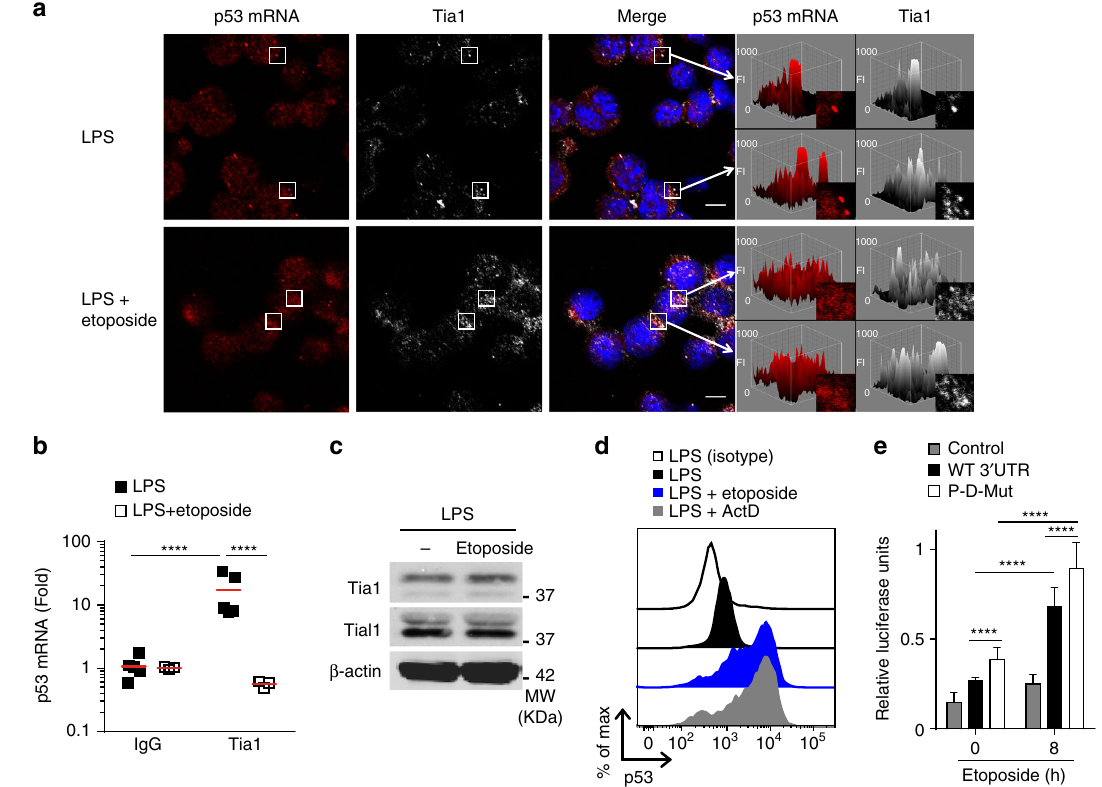
Fig. 6 p53 mRNA is stored within stress granules. a Subcellular localization of p53 mRNA and Tia1 protein in LPS-activated B cells treated or not with etoposide. Fluorescence intensity 3D maps were generated for two regions ( white boxes ) to visualize Tia1 protein and p53 mRNA accumulation in cytoplasmic stress granules. Z axis of 3D maps relates to fl uorescence intensity (FI). Representative images shown are from one of the two independent experiments performed in which a minimum of fi ve confocal images were analyzed. Data extended in Supplementary Fig. 5a ( Scale bar = 5 μ m). b Tia1 protein: p53 mRNA co-immunoprecipitation in LPS-activated B cells treated or not with etoposide. An IgG isotype antibody was used as negative control in these RIP assays. Data are from two independent experiments. In each experiment, 1 – 3 experimental replicates were performed per condition (Mann – Whitney test, **** P < 0.0001). c Immunoblot analysis of Tia1, Tial1 and β -actin in B cells activated with LPS and treated or not with etoposide. d Analysis by intracellular fl ow cytometry of p53 protein expression in B cells activated with LPS for 48-h prior treatment with etoposide (20 μ M) or actinomycin D (5 μ g ml − 1 ) for 4 h. Data from one of the three independent experiments performed are shown in c , d . e Quantitation of renilla luciferase mRNA translation in HEK293 cells transfected with a psiCheck2 empty (control), a psiCheck2-p53 3 ′ UTR (WT) or a psiCkeck2- p53 3 ′ UTR P-D-mutant (P-D-Mut) vector and treated with etoposide (20 μ M) for 8 h. Data from three independent experiments are shown as relative luciferase